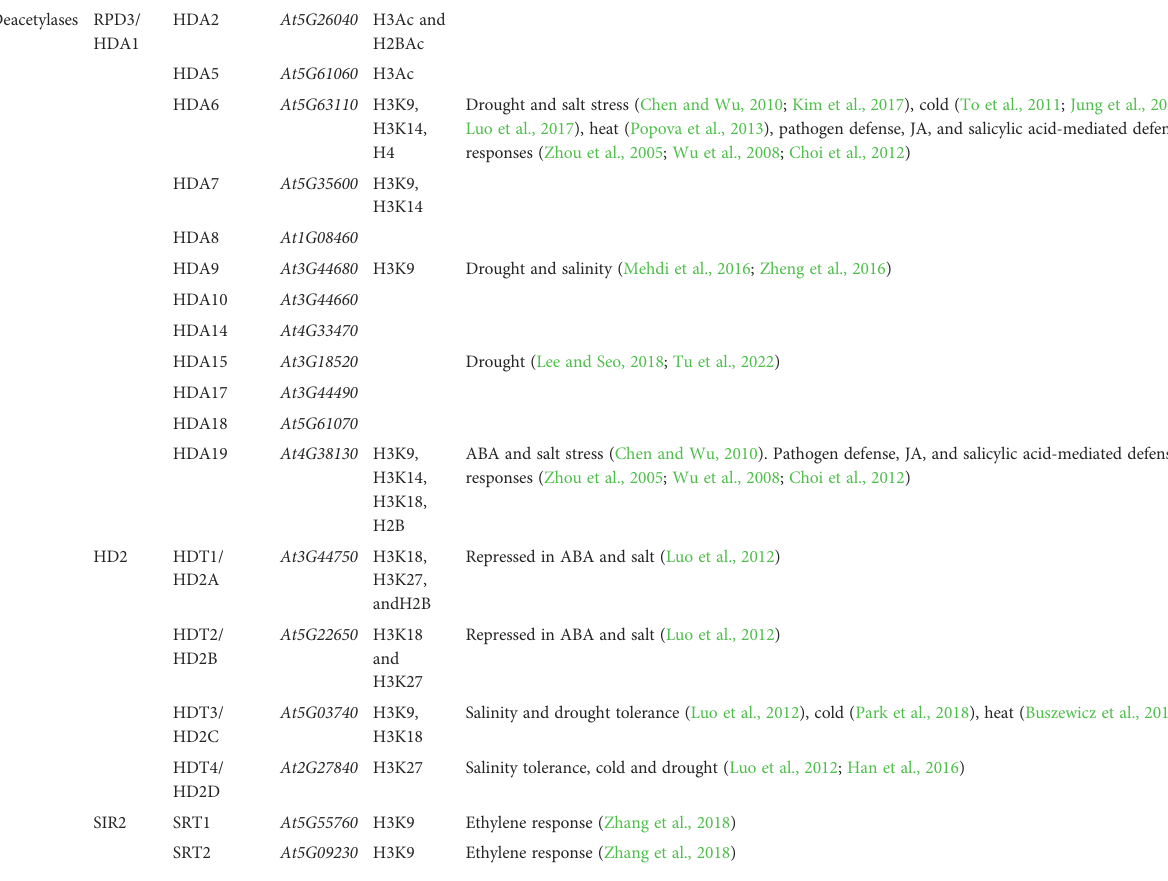
TABLE 3 Classi fi cation of histone deacetylases in Arabidopsis . Enzyme